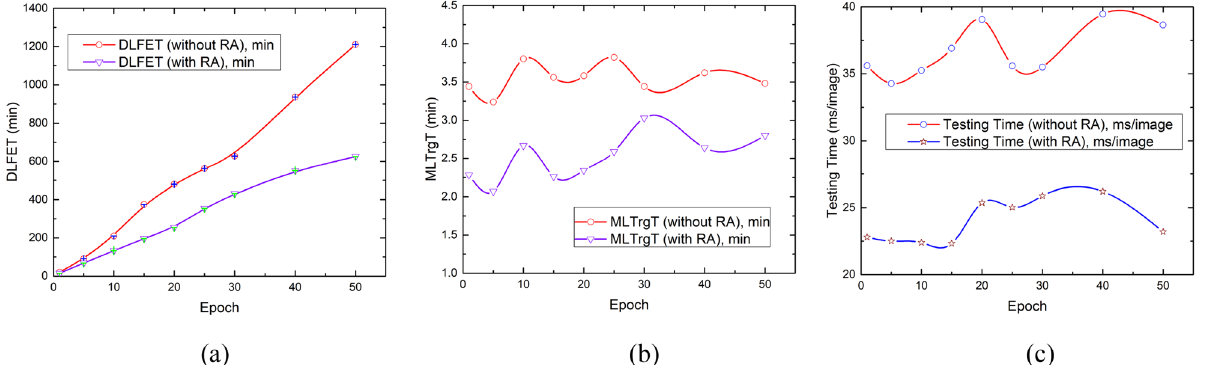
Figure 17. Effect of RA on time required for ( a ) deep learning feature extraction time (minutes), ( b ) ML training time and ( c ) ML testing time for radiogenomic classification using BraTS-2021 dataset and 1-NN